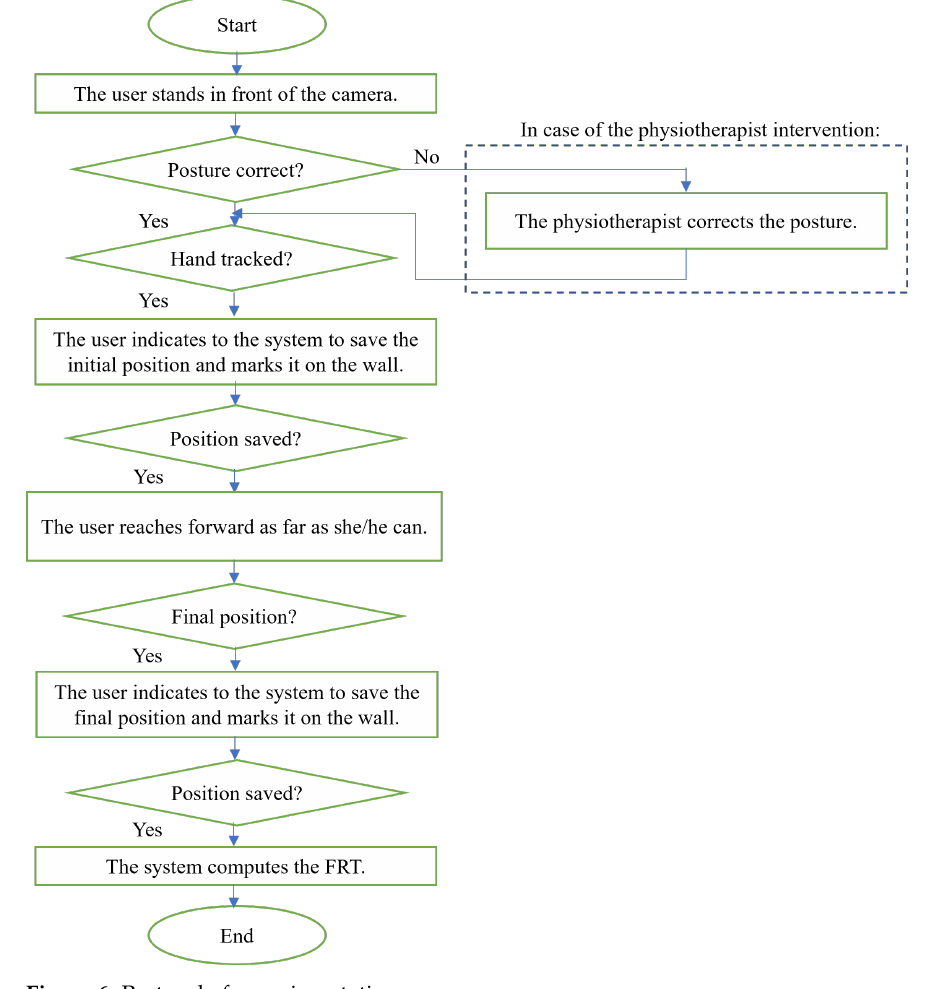
Figure 6. Protocol of